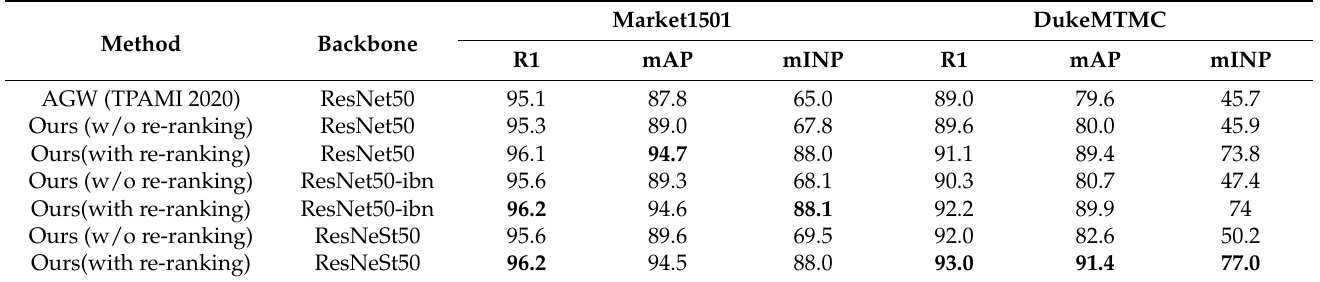
Table 3. Person re-ID performance comparison with various backbone settings on the Market1501 and DukeMTMC datasets (Boldface indicates the best